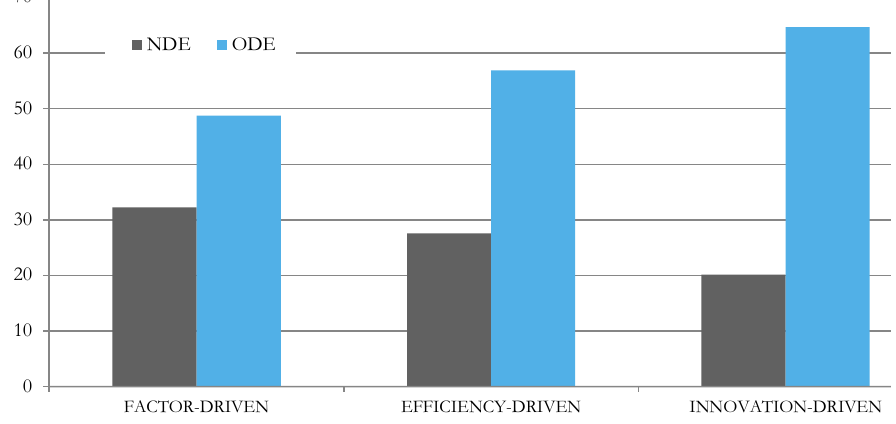
Fig. 2 – Average of entrepreneurial activities. Source: own research